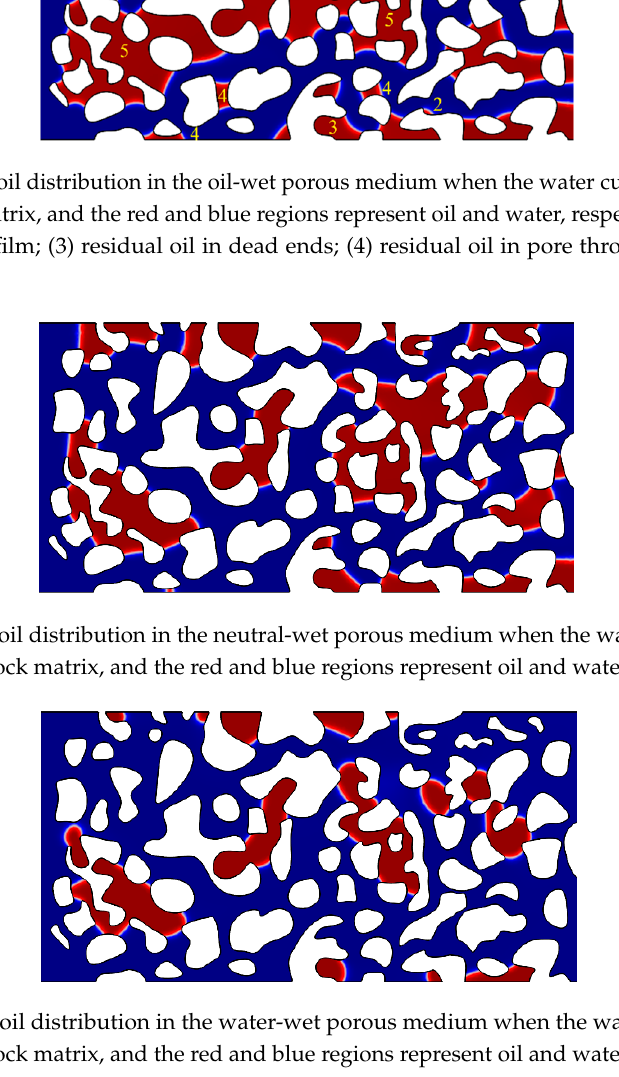
Figure 5. Residual oil distribution in the water-wet porous medium when the water cut is 98%. The white regions are rock matrix, and the red and blue regions represent oil and water, respectively.